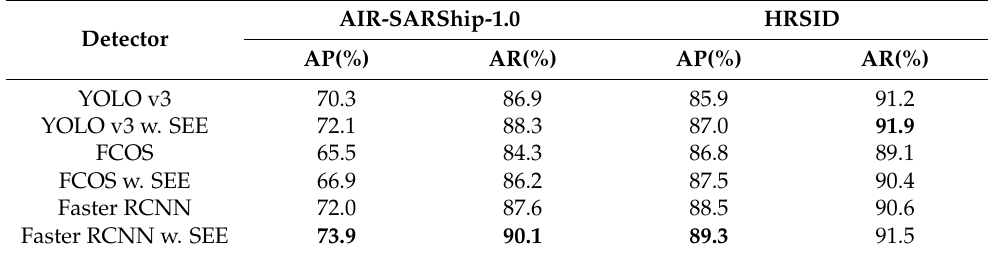
Table 2. Experiment results for the SEE module on two SAR